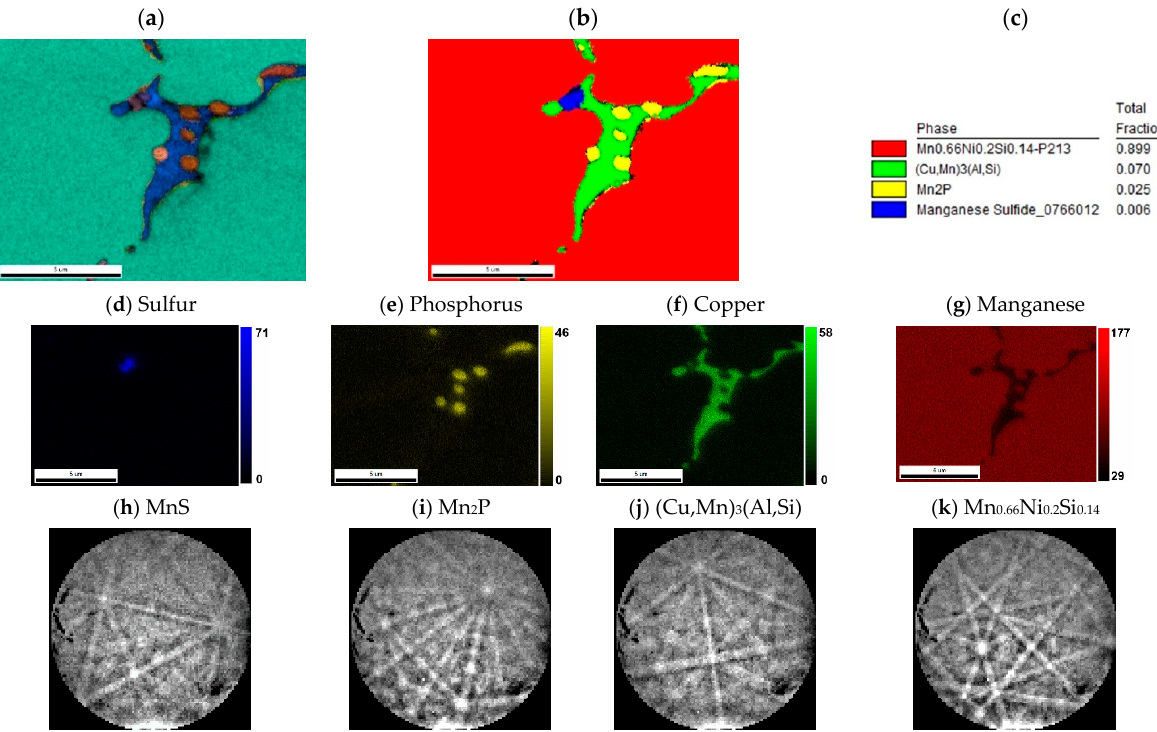
Figure 4. Detail of minor phases in sample with stoichiometric amount of aluminum. ( a ) IPF map overlayed on a greyscale Image Quality map; ( b ) phase distribution map overlayed on a Confidence Index map, whose color code and percentage of area coverage are given in ( c ). The middle line shows EDS results of ( d ) sulfur, ( e ) phosphorus, ( f ) copper, and ( g ) manganese distribution; scales give the intensity of respective peaks. The bottom line shows Kikuchi patterns of ( h ) MnS, ( i ) Mn 2 P, ( j ) (Cu,Mn) 3 (Al,Si), and ( k ) Mn 0.66 Ni 0.2 Si 0.14